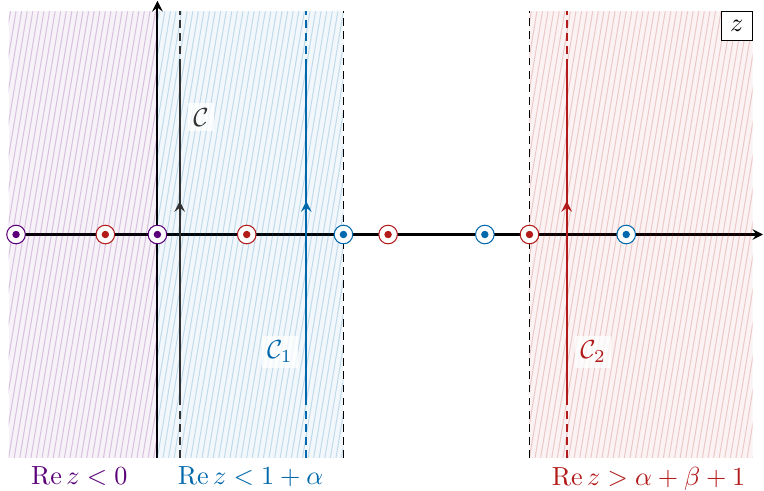
Figure 10. Regions of analyticity of the Mellin transforms (A.9) and (A.10) and contours of integration for the inverse transform (A.12). As we drag C 1 and C 2 into C , we only pick up contributions from the poles of M f 2 (1 − z )